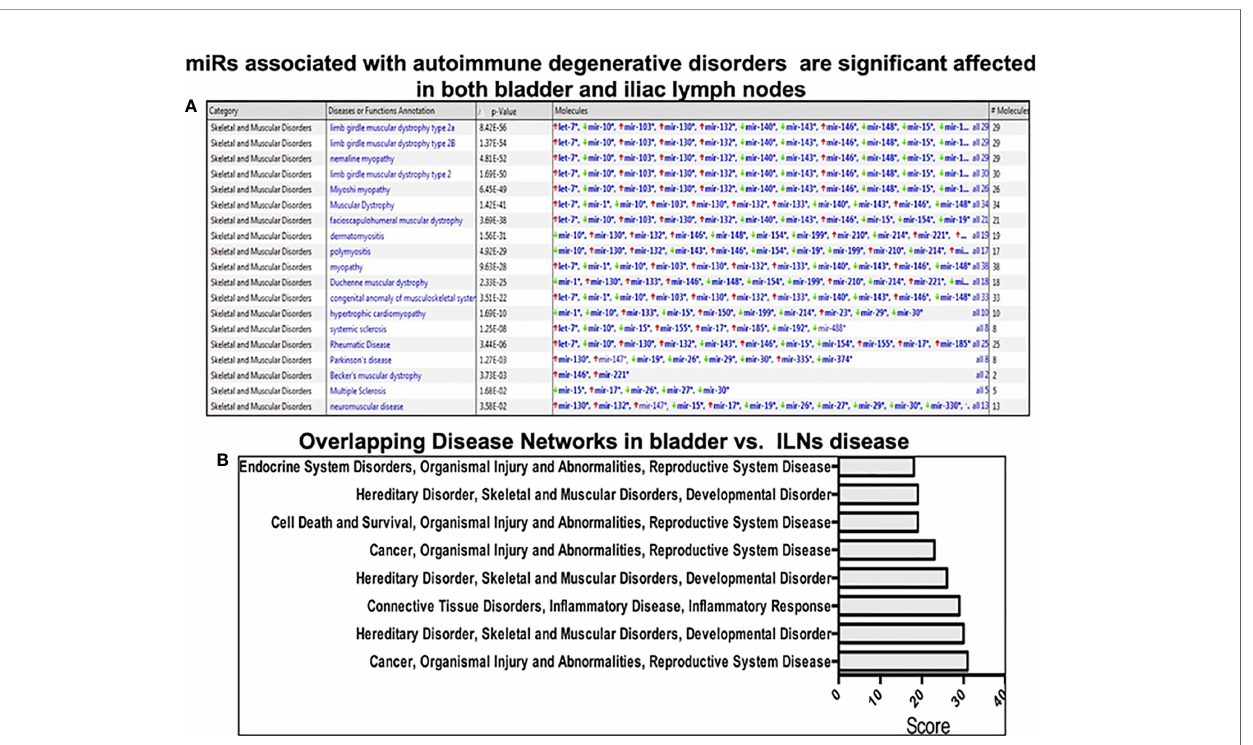
FIGURE 3 | Pathway analysis using Ingenuity software during IC development. (A) The upper panel shows miRs associated with the autoimmune degenerative disorder in the urinary bladder and iliac lymph nodes. (B) Top ingenuity pathways analysis (IPA) overlapping disease-associated networks between tissue types in both urinary bladder and iliac lymph